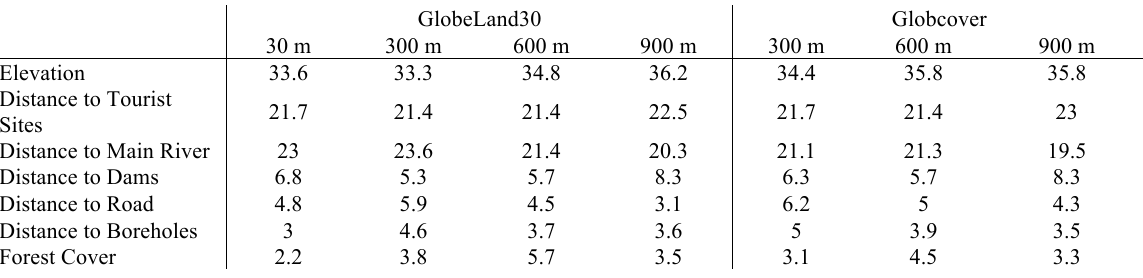
Table 2. Percent contribution of each parameter for each model, categorized by spatial resolution and land cover classification